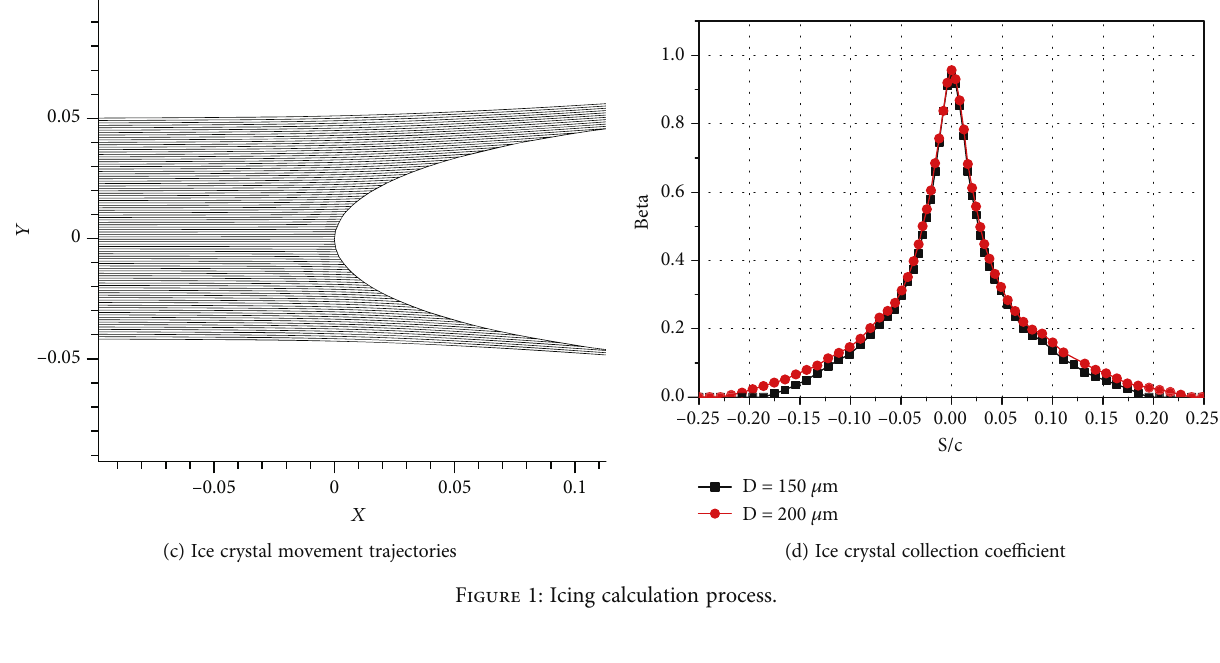
Figure 1: Icing calculation